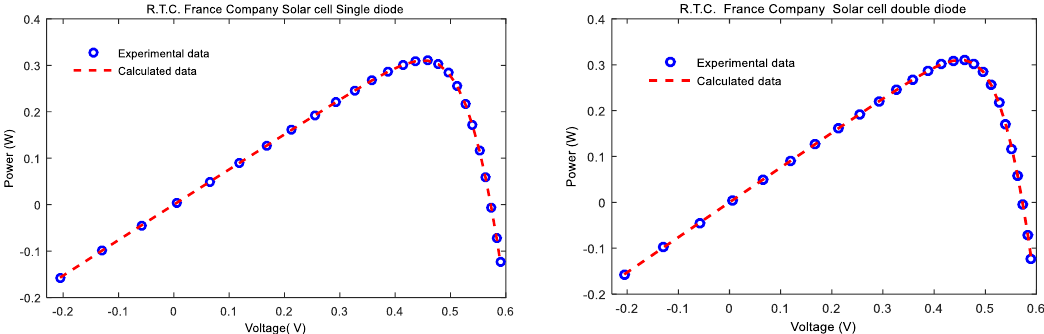
Figure 8. Experimental power-voltage data compared with estimated data of the mono-crystalline silicon solar cell single double diode, RTC France Company.